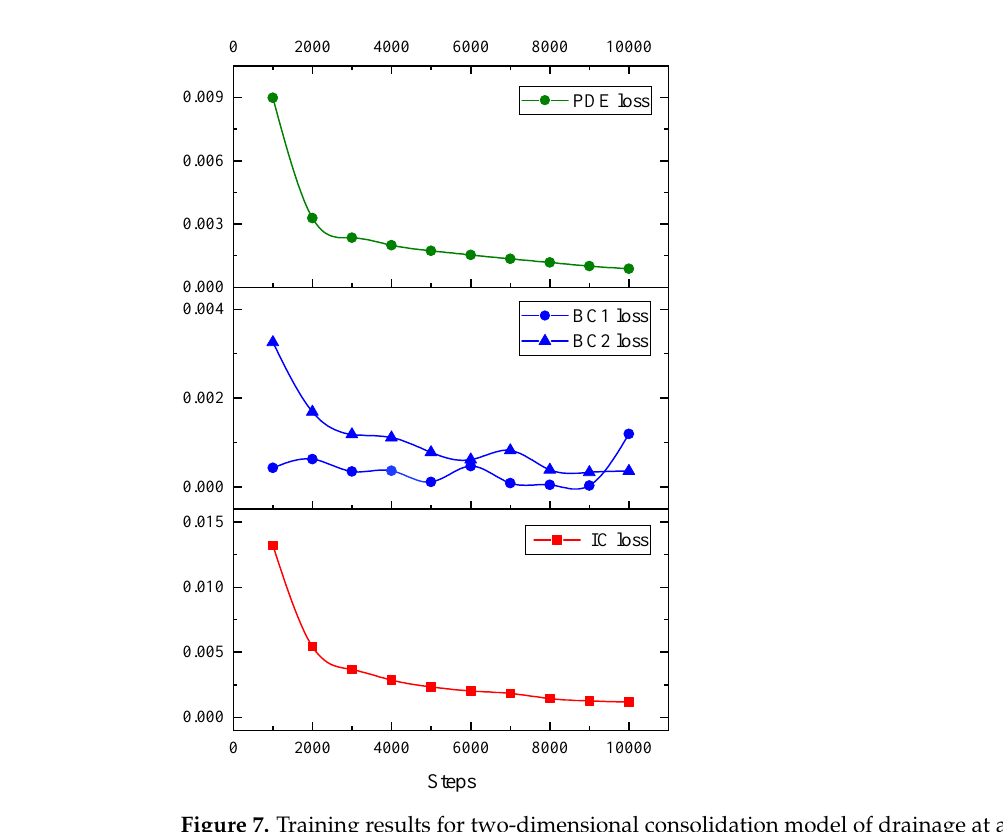
Figure 7. Training results for two-dimensional consolidation model of drainage at a top boundary.